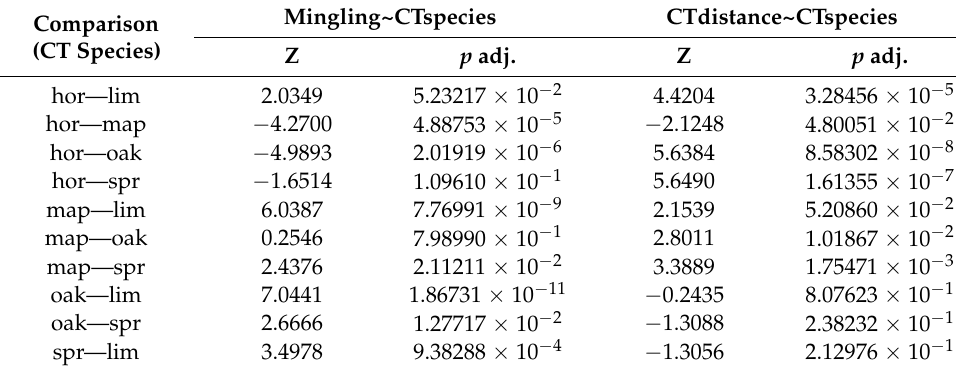
Table 2. Pairwise comparison (Dunn test) of the influence of the large central tree (CT) species (hor— Carpinus betulus , map— Acer platanoides , oak— Quercus robur , spr— Picea abies , lim— Tilia cordata ) identity on mingling index and pairwise comparison of the large central tree species identity’s influence on the distance to the nearest